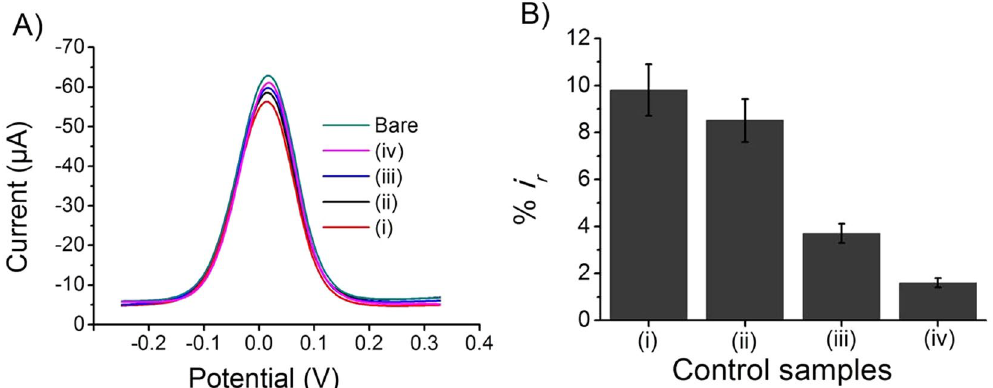
Figure 3. Control experiments. Typical differential pulse voltammetry signals ( A ) and corresponding relative current changes ( B ) obtained at the electrodes modified with ( i ) HER-2 antibody + FAM134B protein, ( ii ) FAM134B antibody + HER-2 protein, and (iii, iv) FAM134B proteins knockout SW48 (out 1) and SW480 (out 2). Each data point represents the average of the three separate trials ( n = 3) and error bars represents the standard deviation of measurements within